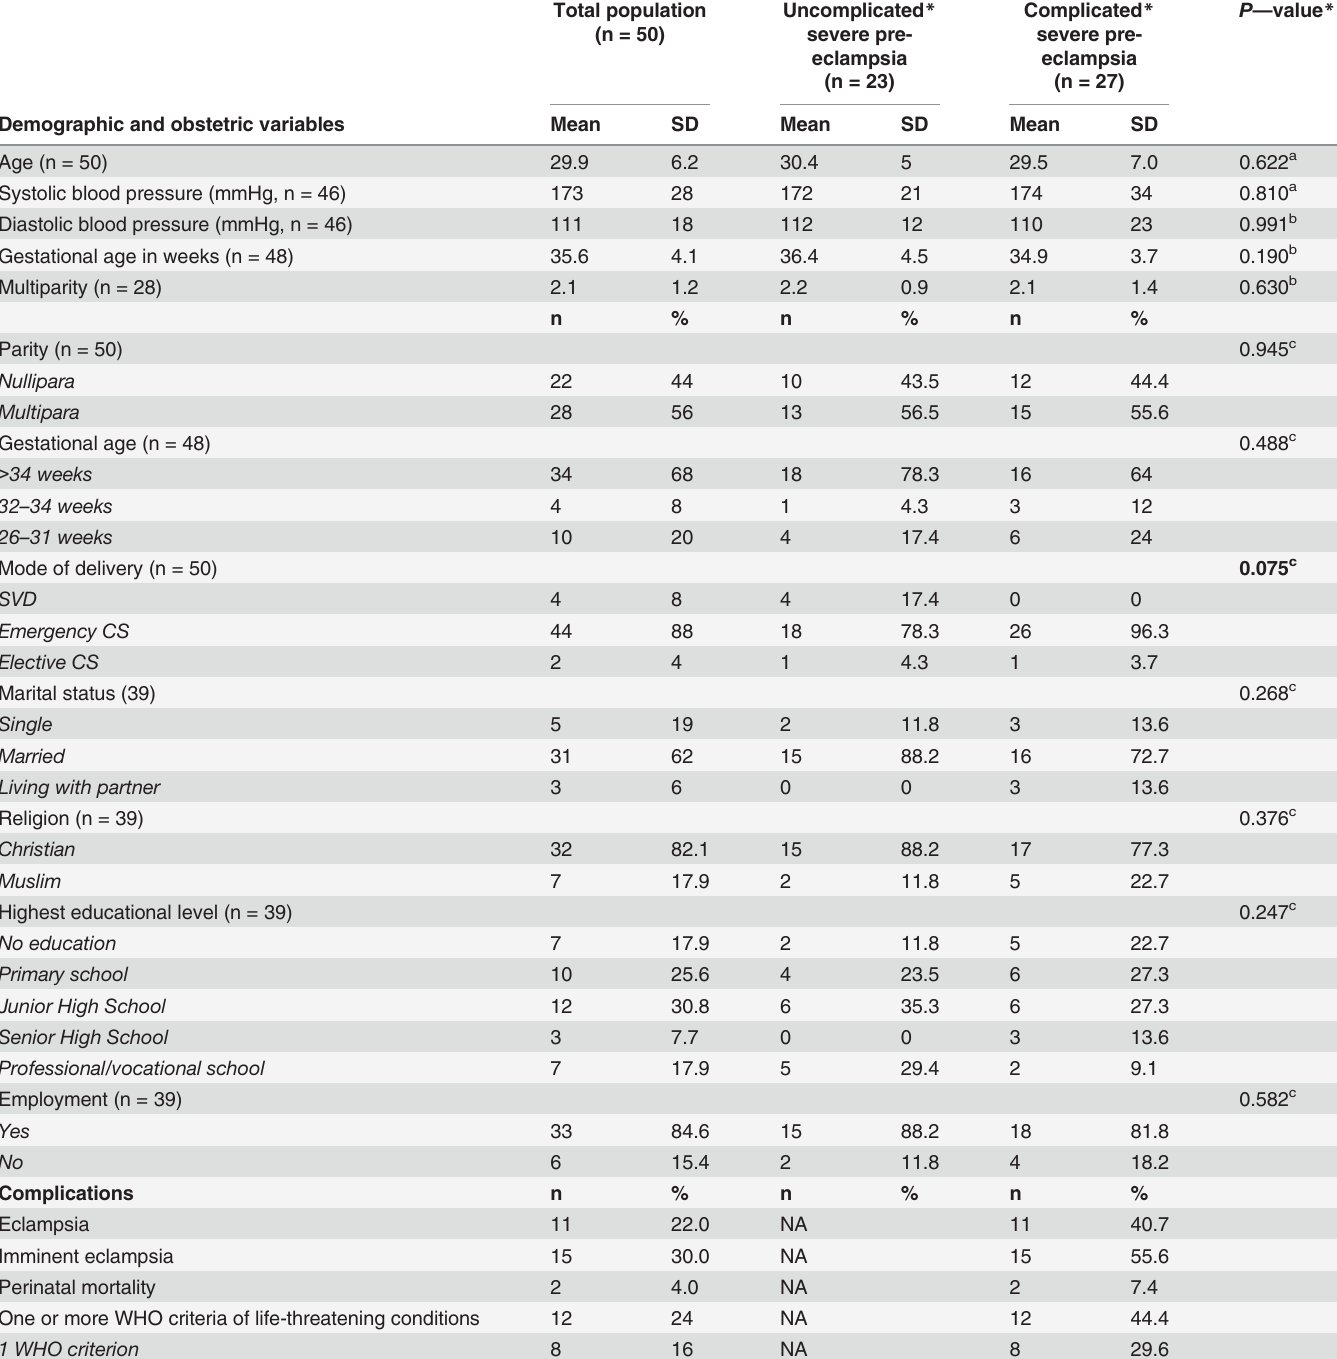
Table 2. Baseline characteristics of study population and incidence of complications, stratified by uncomplicated and complicated severe pre- eclampsia (n = 50), Ridge Regional Hospital, Accra, Ghana, 2013.